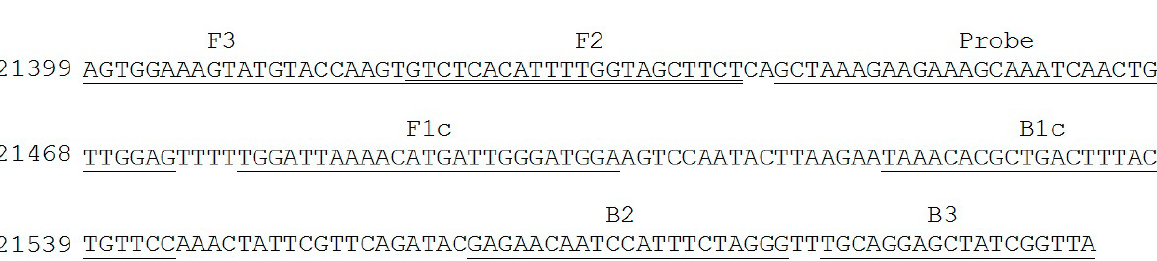
Figure 1. Position of primer and probe on p30 gene, Accession No.